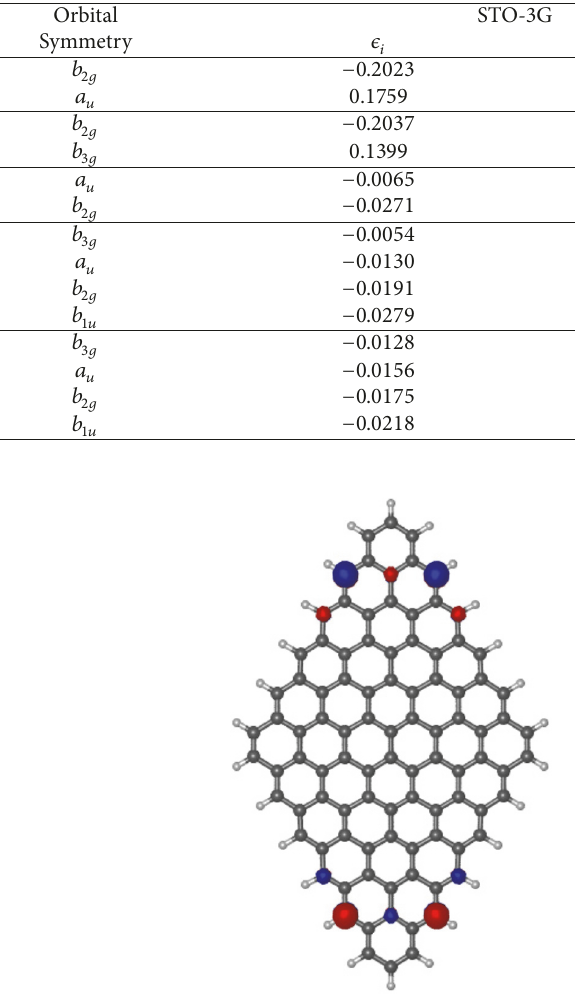
Figure 13: R 6 magnetic orbital